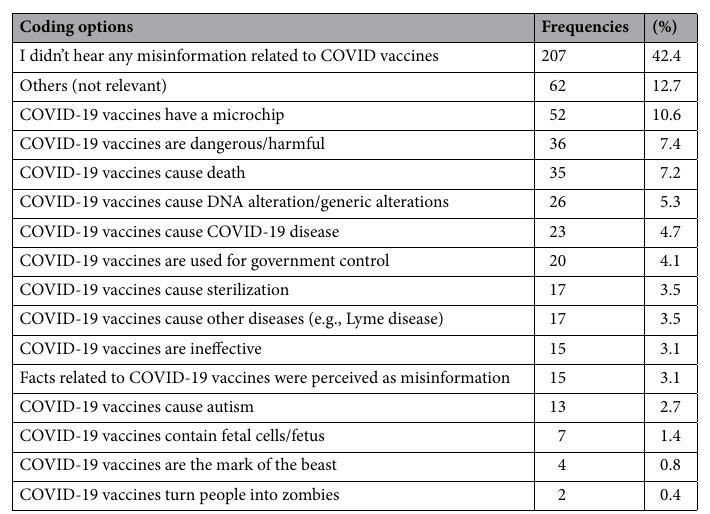
Table 1. Vaccine misinformation and false claims identified in Study 1. The total number does not add up to the sample size of 488 and the sum of percentage scores go over 100% since some participants gave more than one answer about misinformation they